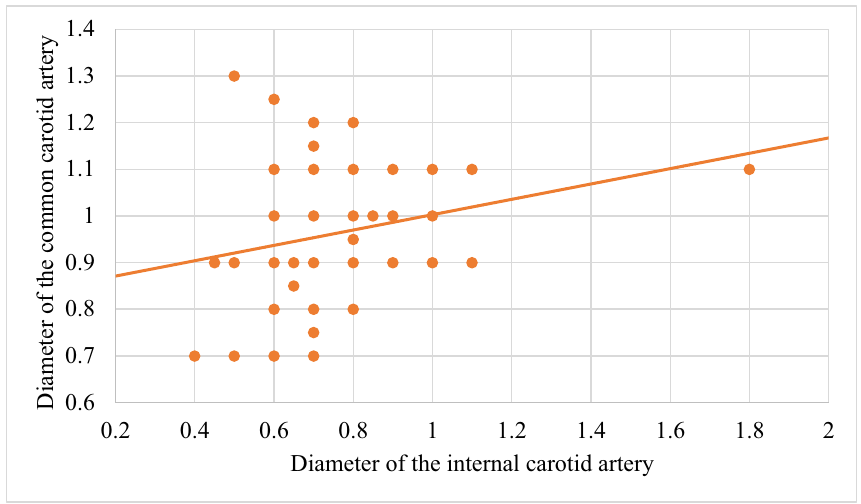
Figure 4. Correlation between the diameters of the common carotid artery and the internal carotid artery.